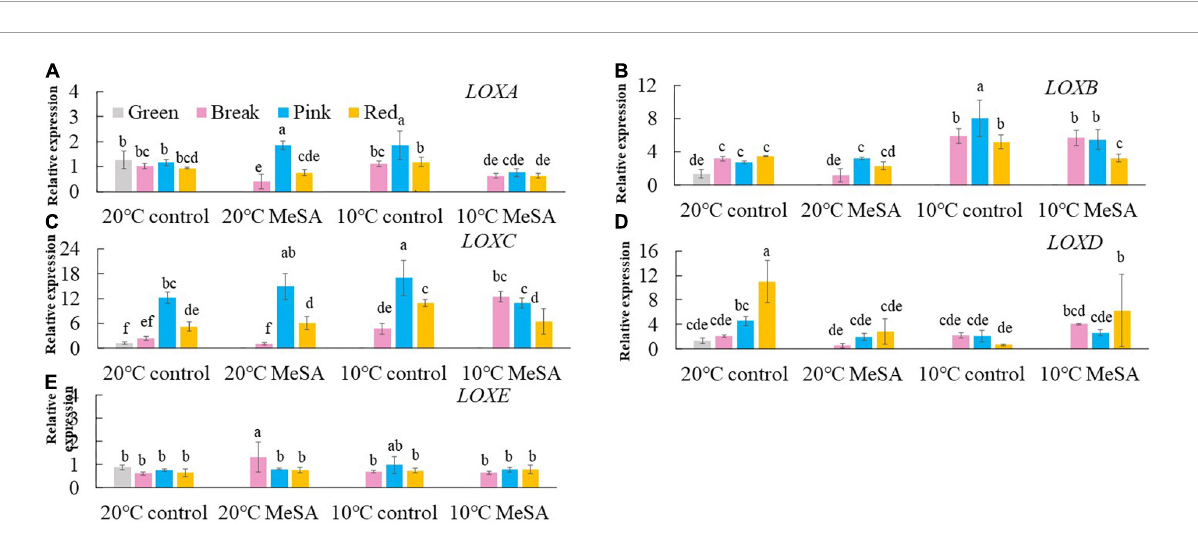
FIGURE3 Effects of methyl salicylate (MeSA) pre-treatment on the relative expressions of LOXA (A ), LOXB (B) , LOXC (C) , LOXD (D) , and LOXE (E) genes in tomato fruits stored at low temperature. Data are expressed as mean ± SD ( n = 3), repeated measures one-way ANOVA followed by DMRT. Data marked with the same letter were no significant difference at p <